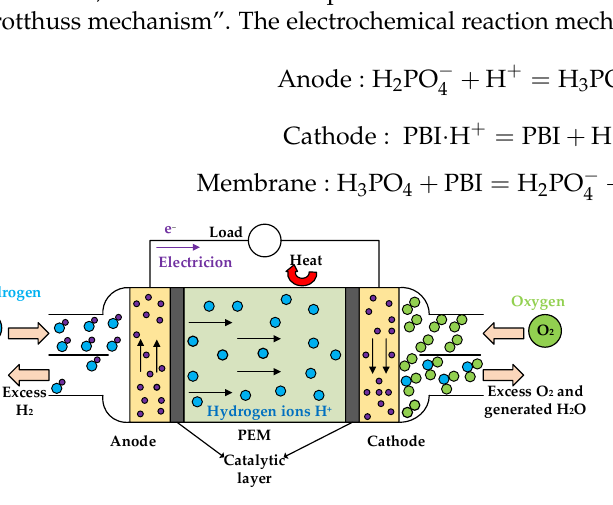
Figure 10. Reaction mechanism of HT-PEMFCs.